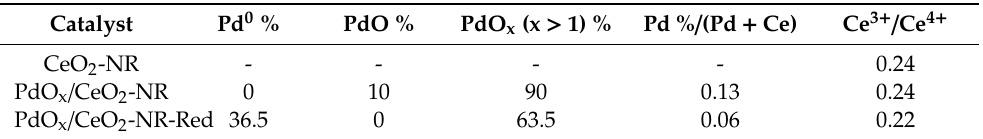
Table 2. Atomic percent values of palladium species in PdO x /CeO 2 -NR and PdO x /CeO 2 -NR-Red, collected from XPS study.